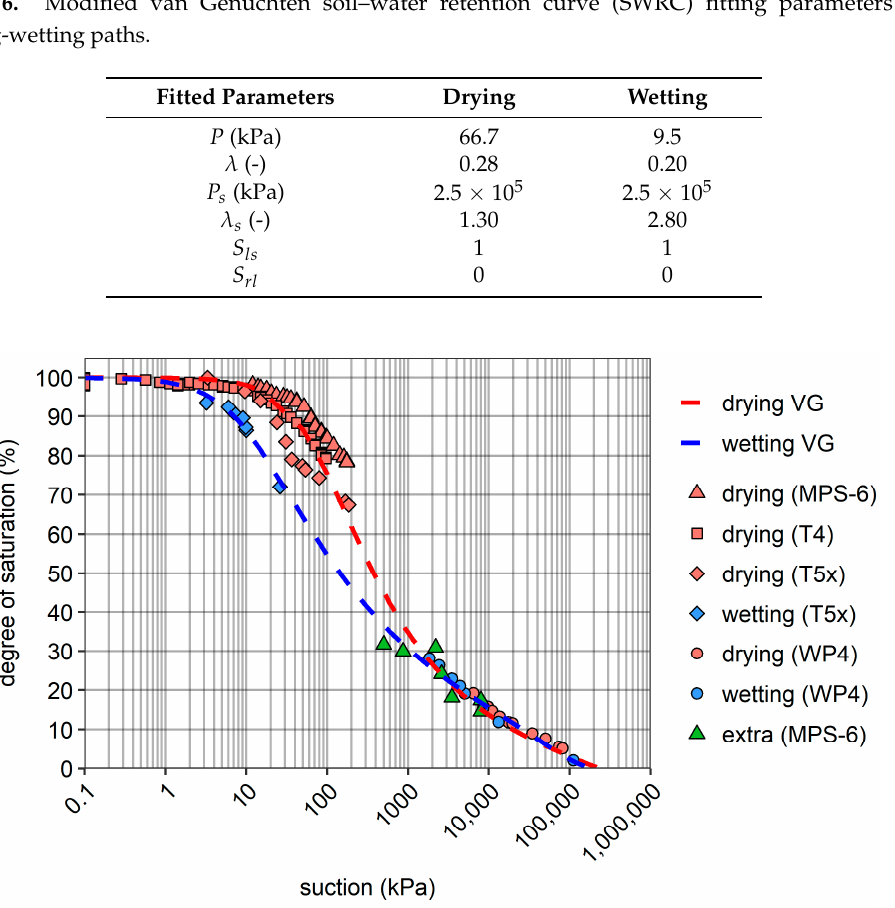
Figure 9. SWRC obtained by laboratory tests using different sensors. The resulting curves were calculated for drying-wetting conditions applying the modified van Genuchten (VG) model.